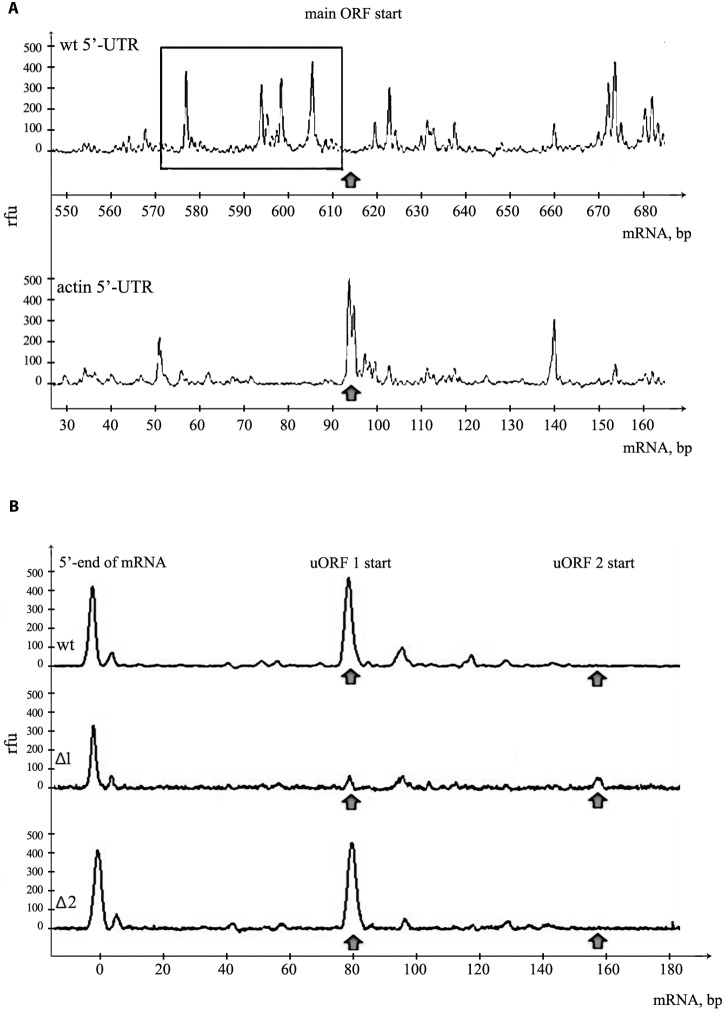
Assembly of 48S initiation complexes on mRNA with PKMζ 5′UTR.
(A) Toe-print analysis of ribosomal complexes on mRNAs containing PKMζ or actin leader sequences and main ORF of luciferase. The area adjacent to the start of the main ORF is shown. Arrow indicates the position of AUG codon of the main ORF. Hairpins on 5′UTR of PKMζ are selected by rectangle. (B) Toe-print analysis of mRNAs containing wt and mutated leaders of PKMζ (Δ1 and Δ2). The beginning of 5′UTR is shown. Rfu, related fluorescence units. Arrows indicate the positions of 48S initiation complexes on uORFs.